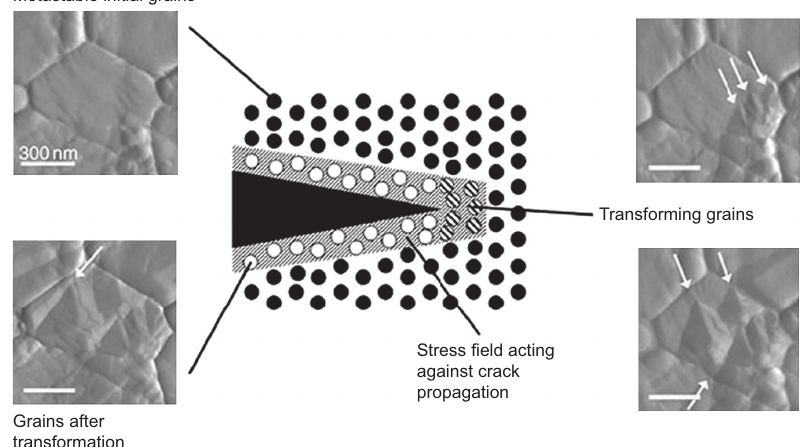
Figure 3 Schematic illustration of the transformation-toughening mechanism in tetragonal zirconia polycrystalline (TZP) ceramics, as visualised by atomic force microscopy